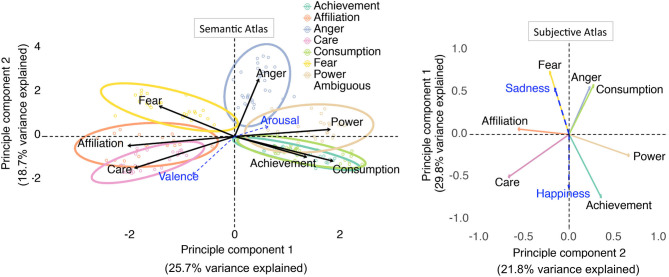
A semantic and subjective atlas of seven motives. (Left)
A semantic atlas of seven motives. Principle component analysis (PCA) of a word categorization task in which participants were to assign words (points) to 1 of 7 motivational categories (arrows). Dots depict words more frequently attributed to one motivational category than any other (p < 0.05) are surrounded by 95% confidence ellipses. Words that did not have this property are labeled “ambiguous.” They were included in the PCA analysis but are not depicted (i.e., in white) to reduce visual clutter. Blue arrows represent how the valence and arousal of all words related to the PCA space. (Right)
A subjective atlas of seven motives. Principle component analysis (PCA) of a self-report task in which participants were to rate on a visual analog scale how well a number of motive-specific words obtained in the first study described their spontaneously experienced motives and feelings at that moment.